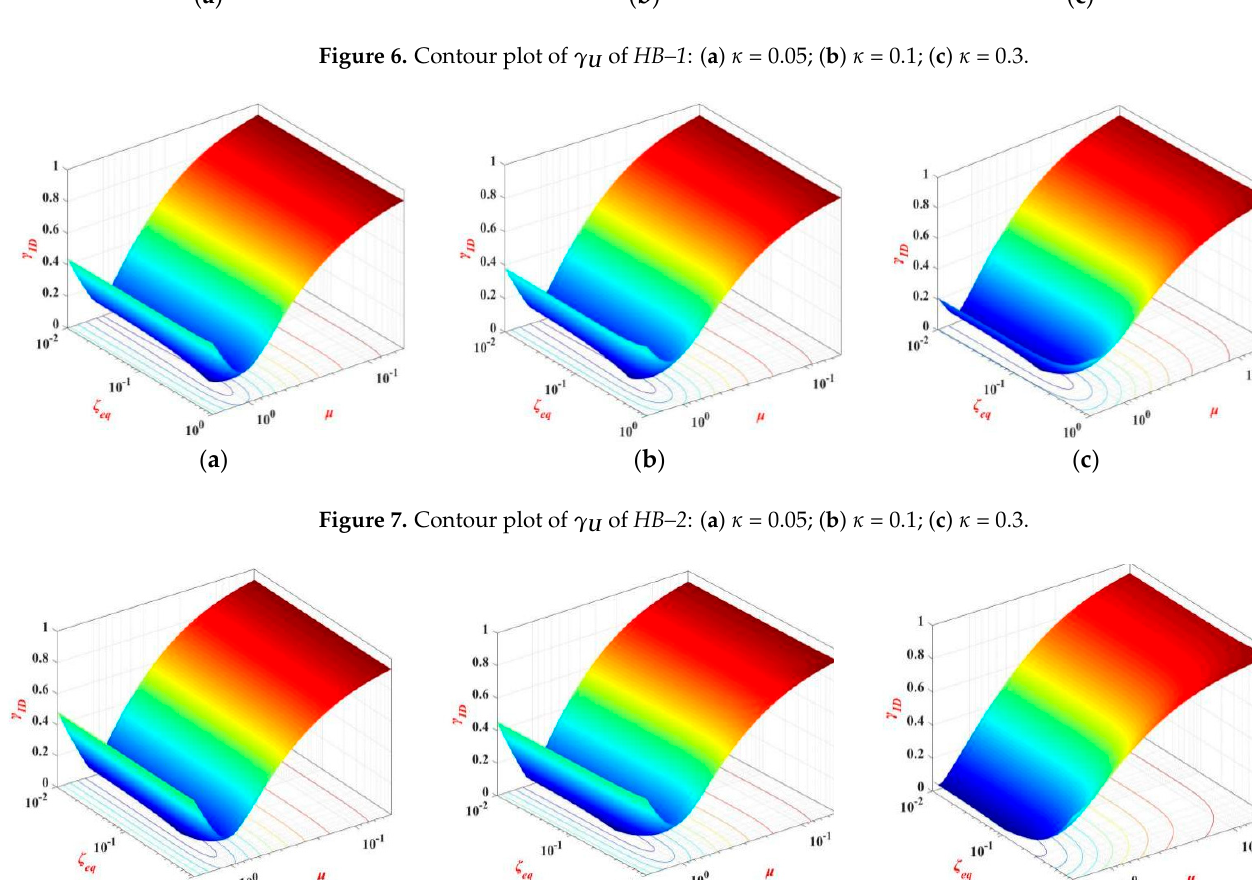
( c ) Figure 9. Contour plot of γ U of LB–2 : ( a ) κ = 0.05; ( b ) κ = 0.1; ( c ) κ = 0.3. The γ ID is the ratio of the displacement ratios of the isolation layer of the two isolation systems, so the damping ratio has little effect. Only low–frequency bushings (LB–2) show large fluctuation at κ = 0.3. However, γ ID is greatly affected by the inerter–mass ratio, and like γ U , will decrease with the increase of inerter–mass ratio within a certain range. How- ever, when the inerter–mass ratio is between [1,2], the four kinds of bushing γ ID will in- crease with the increase of the inerter–mass ratio. The smaller the frequency ratio is, the more flexible the isolation layer is, and the more ‘steep’ the surface of γ ID is when the inerter–mass ratio is between [1,2], indicating that the restoring force of the isolation layer can not quickly mitigate the additional inertia force generated by the inerter element. Alt- hough increasing the stiffness can reduce this phenomenon, the excessive stiffness of the isolation layer will increase the displacement of the upper bushing. So, when the value of